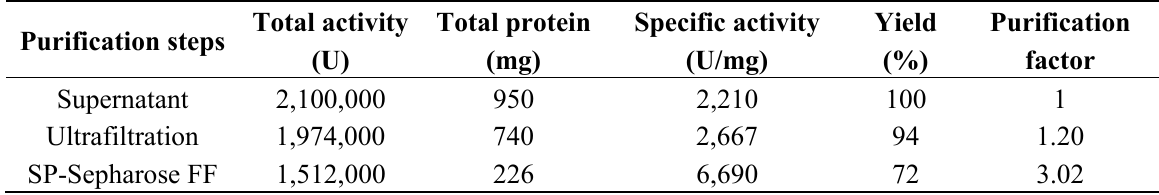
Table 1. Purification of rProROL from 100 mL culture supernatant.